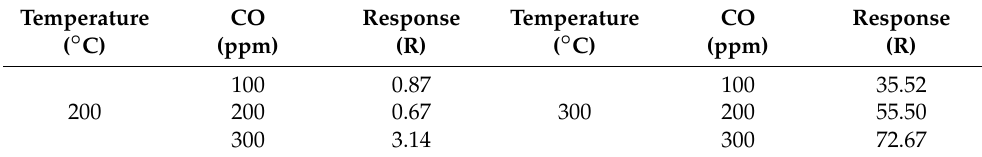
Figure 8. Response of NiSb 2 O 6 nanoparticles obtained at 900 °C in CO atmospheres as a function of ( a ) CO concentration, ( b ) operating temperature. Table 1. Response of NiSb 2 O 6 pellets at different concentrations and operating temperatures.